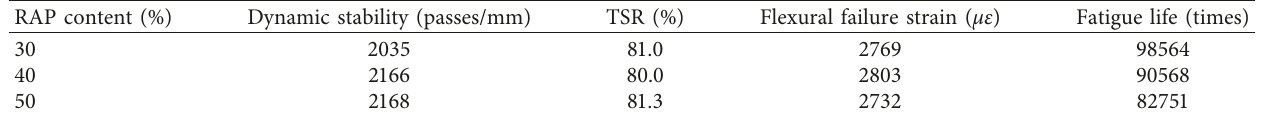
Table 17: Mean value of pavement performance under 100%